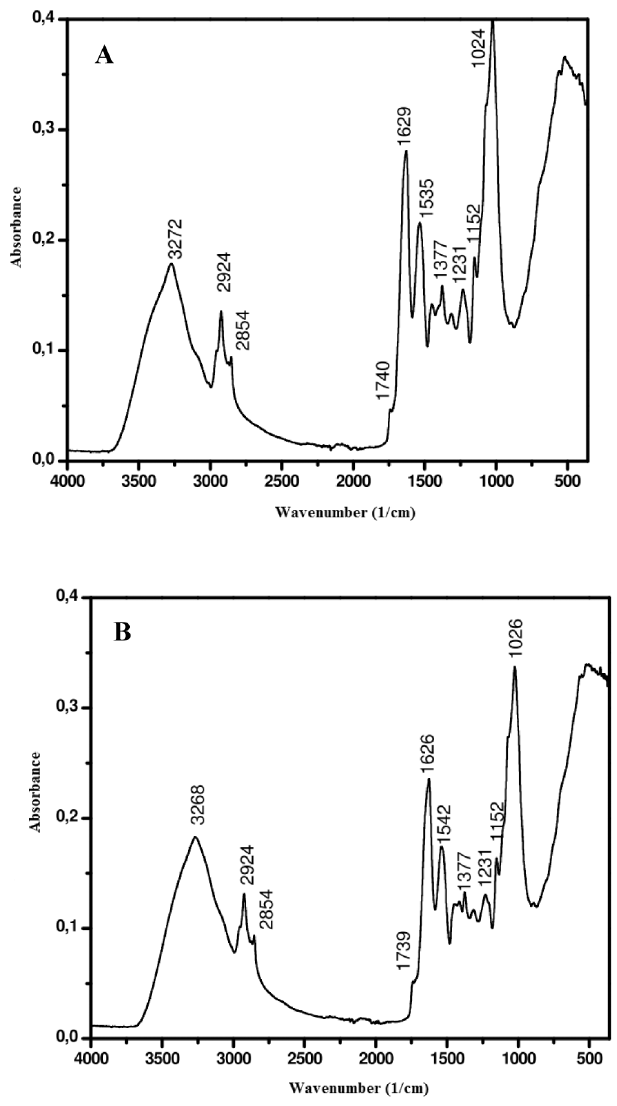
Fig 6. FTIR spectra of dead biomass of H . lixii . (A) Before and (B) After saturation with